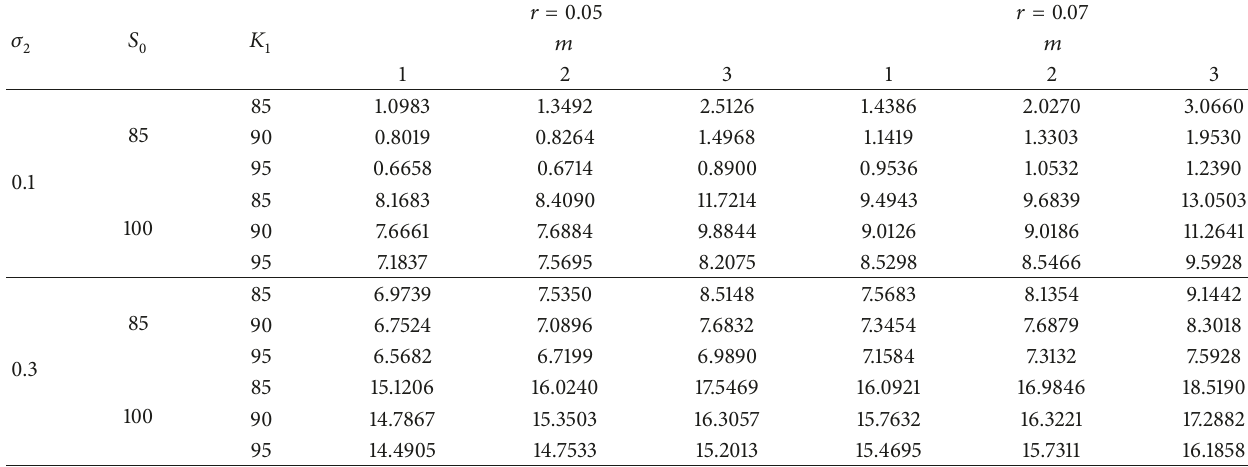
Table 1: Values of the outside-reset option with single strike reset and three reset dates.